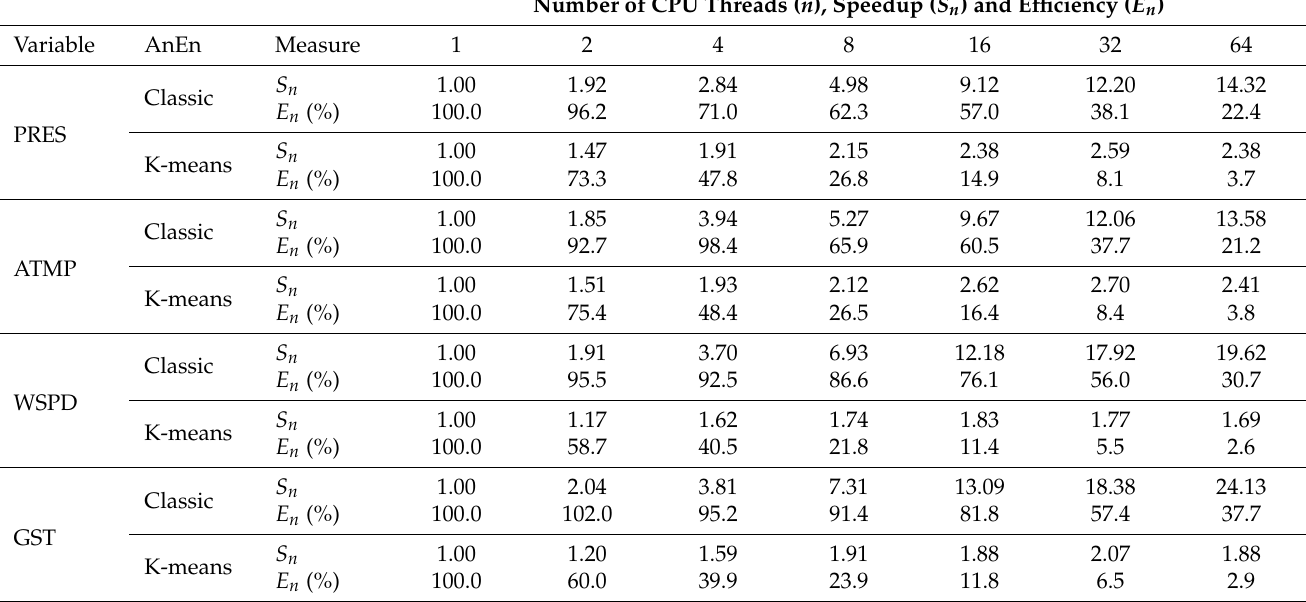
Table 8. Classical AnEn vs. K-means AnEn: Speedup and Efficiency